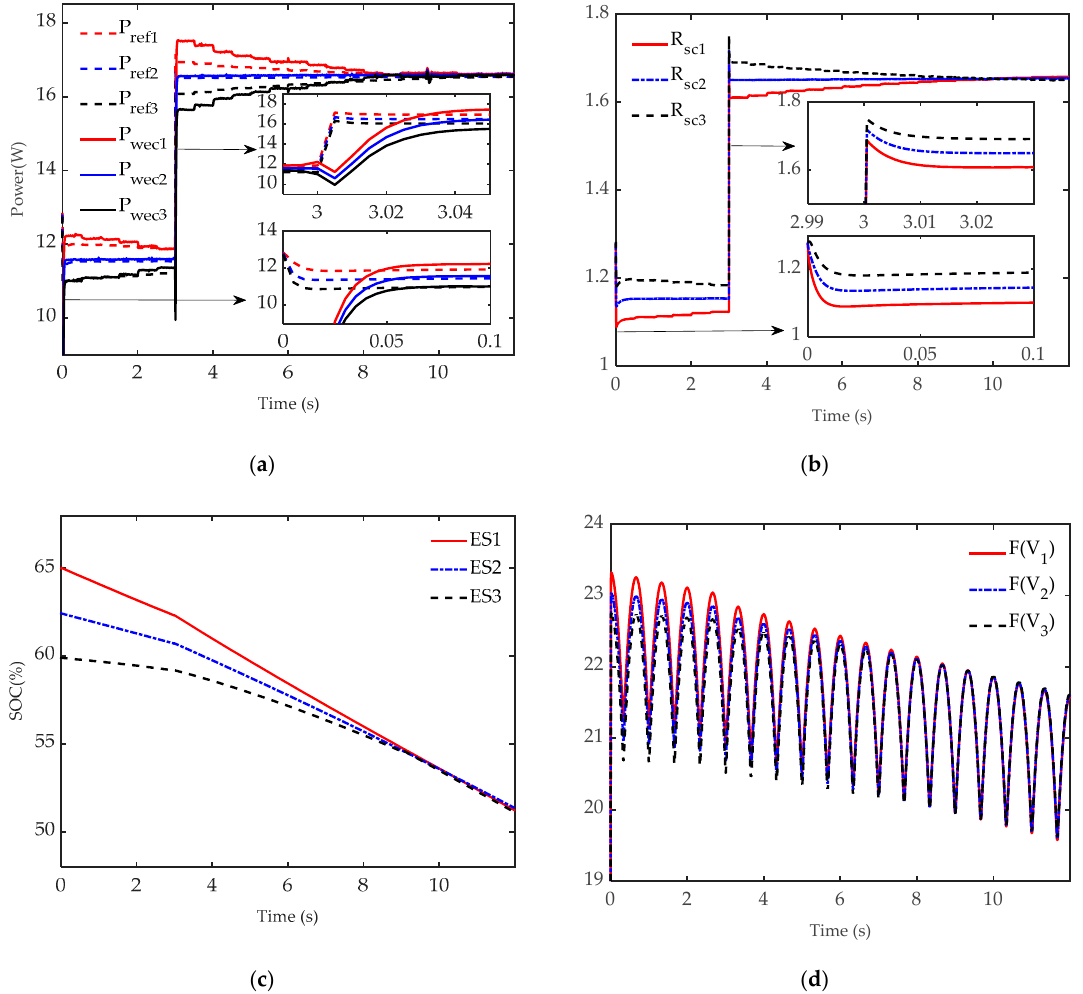
Figure 10. Performance of WECs with different initial SOC: ( a ) Reference output powers and actual output powers of each WEC; ( b ) Power distribution ratio of each ES in each WEC; ( c ) SOC curve; ( d ) WEC integral energy state F ( V i ) , i = 1,2,3.